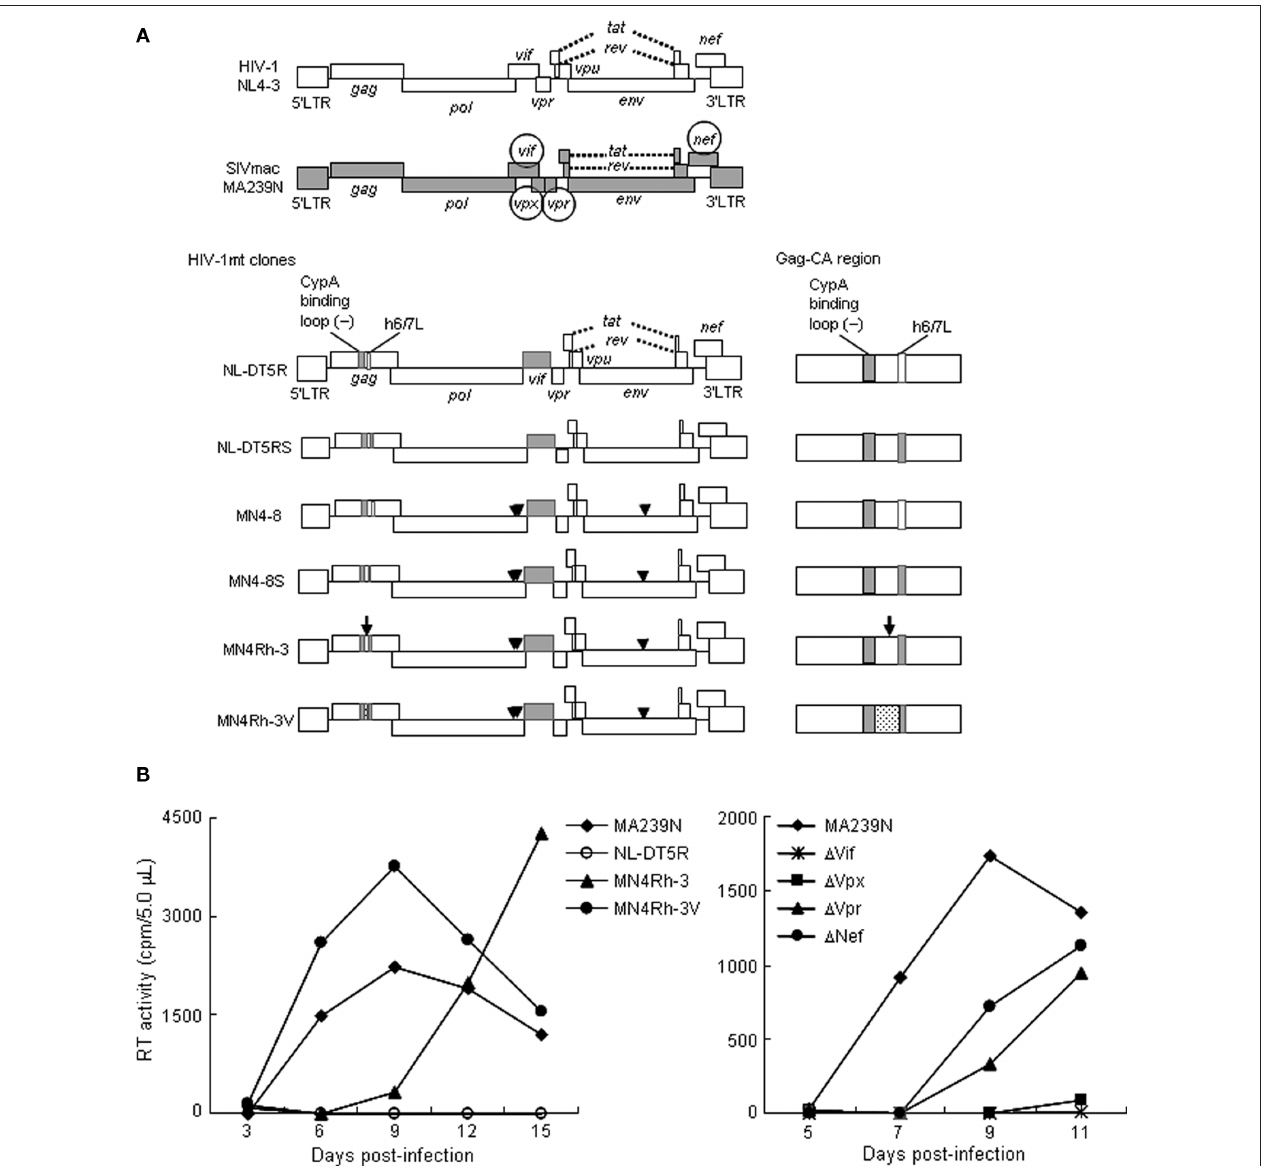
relative to the other clones. Enlarged Gag-CA region is shown on the right. For details, see the text. (B) Replication kinetics of the viruses in M1.3S cells. Cell-free viruses were prepared from 293T cells transfected with proviral clones indicated, and inoculated into 1 × 10 6 cells of M1.3S. Viral replication was monitored at intervals by reverse transcriptase (RT) activity in the culture supernatants. The experiments were done as described previously (Kamada et al., 2006; Doi et al., 2010). For infection, 6.3 × 10 4 and 2.4 × 10 6 RT units of MA239N and HIV-1mt clones (left), respectively, and 5.0 × 10 4 RT units of MA239N clones (right) were used. The representative data in two independent experiments are shown. Replication of NL-DT5RS, MN4–8, and MN4–8S was not detected as observed for